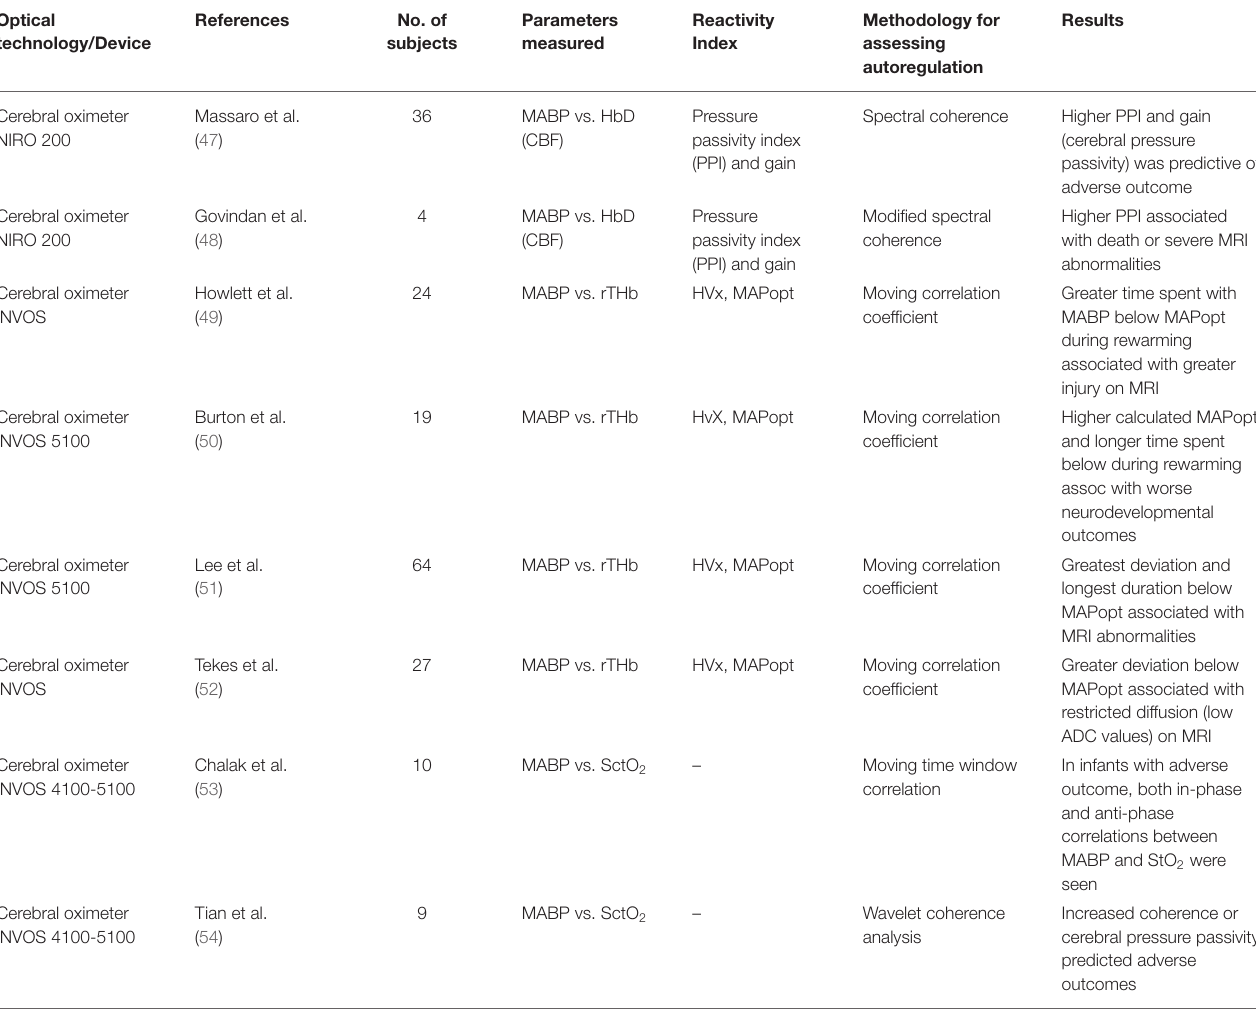
TABLE 2 | Optical studies investigating autoregulatory disturbances in NE. Optical